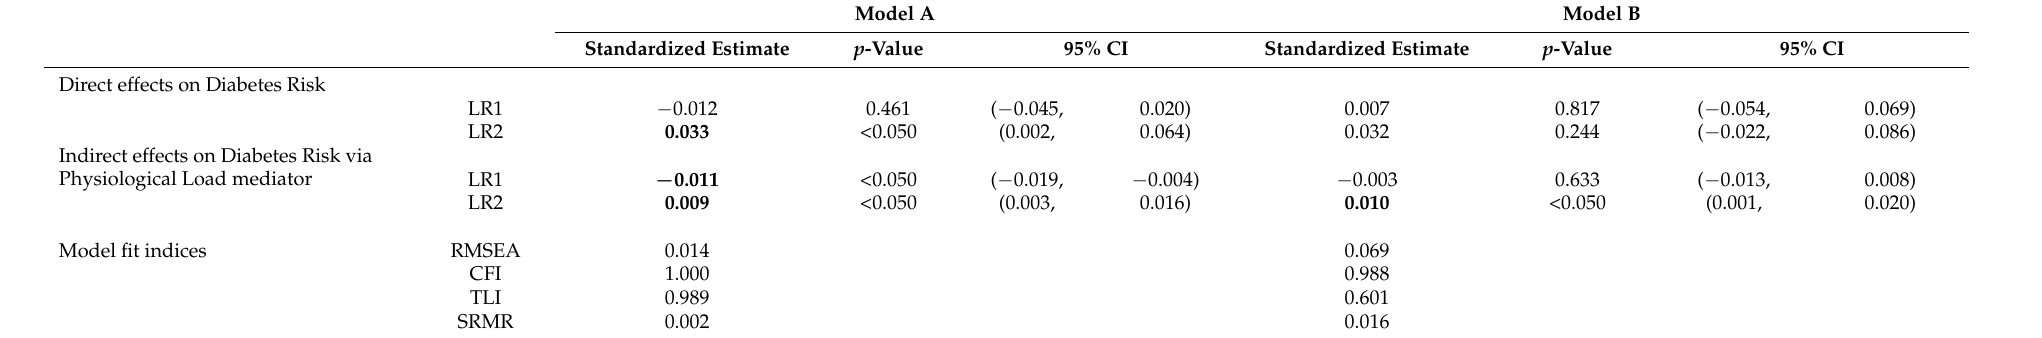
Table 3. Model A and Model B with standardized estimates, p -values and 95% confidence